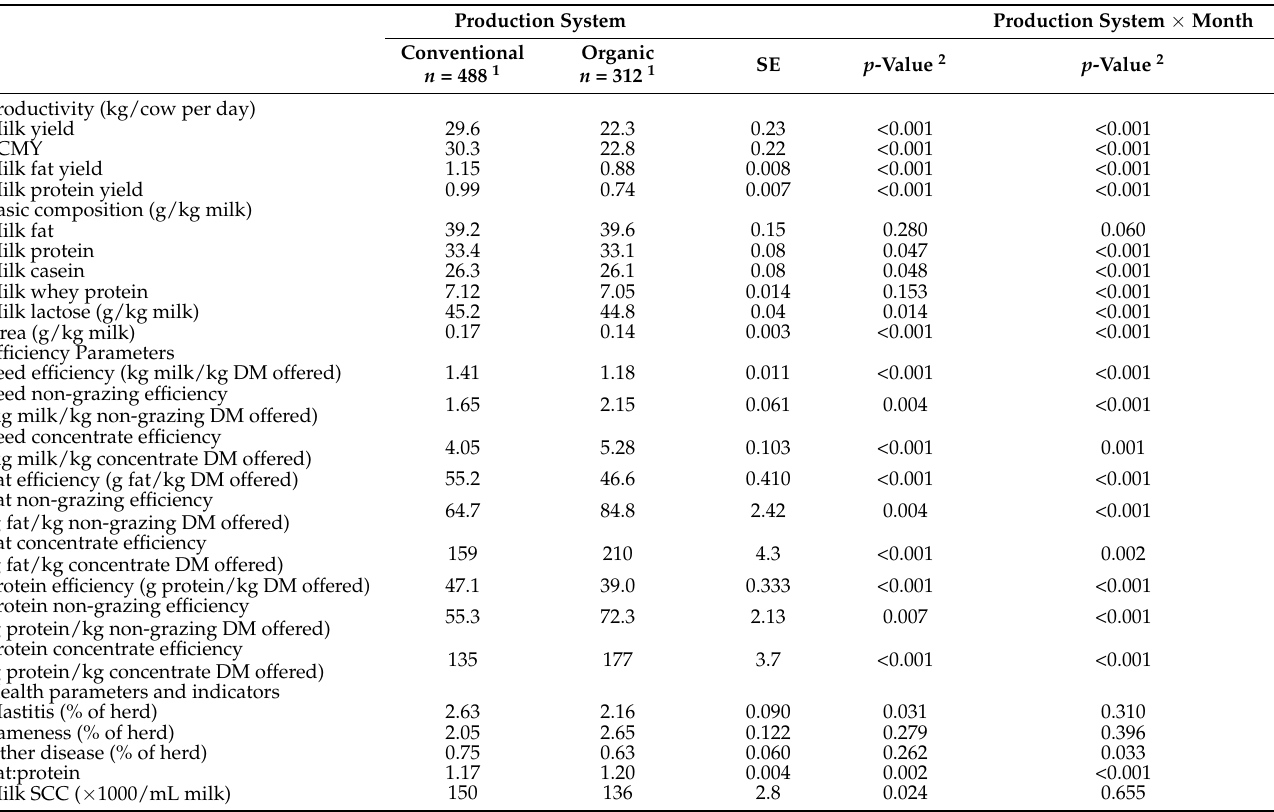
Table 2. Means ± SE and p -values for the effect of differing production systems on milk yield and basic composition, efficiency parameters, and health parameters from 67 farms across Southern England (41 conventional and 26 organic